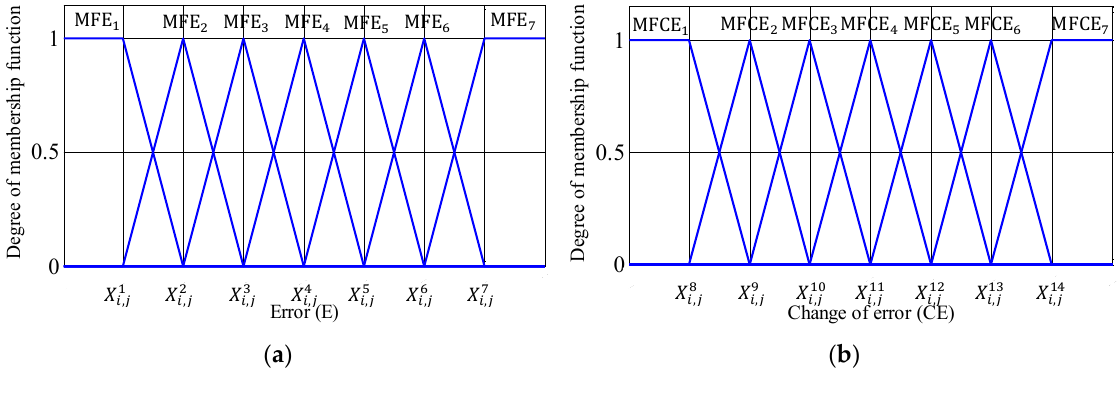
Figure 7. FLC with seven MFs for ( a ) E and ( b ) CE . Table 1. Fuzzy control rules based on seven MFs.